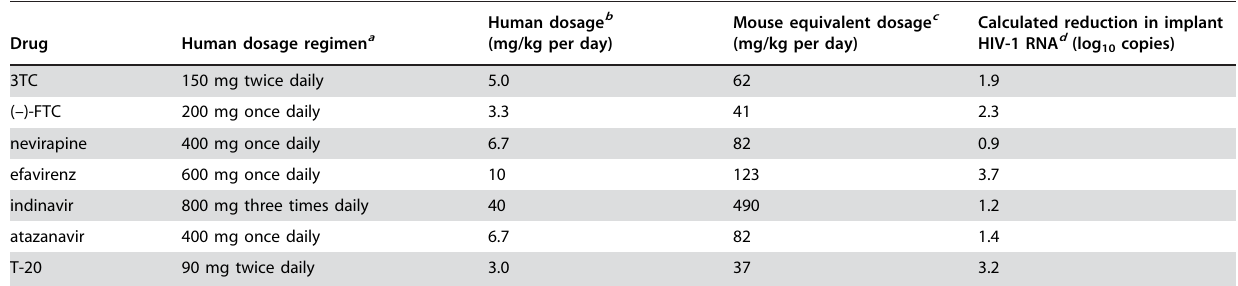
Table 1. Antiretroviral drug dosage levels adjusted for difference in surface area-to-body weight ratio between mice and humans .. ... .... ... ... .... ... ... .... ... ... .... ... ... .... ... ... .... ... ... .... ... ... .... ... ... .... ... ... .... ... ... .... ... ... .... ... ... .... ... ... .... ... ... .